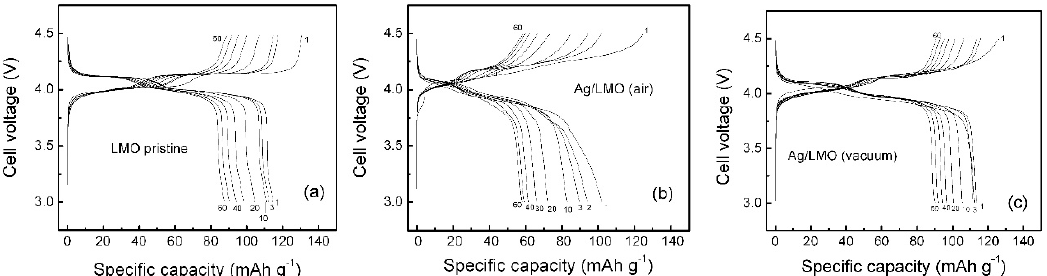
Figure 11. Galvanostatic charge–discharge profiles of Li//LMO cells. Experiments were carried out at 15 mA g − 1 rate in the potential range 3.0–4.5 V over 60 cycles. Positive electrodes are: ( a ) pristine LMO; ( b ) Ag/LMO(a); and ( c ) Ag/LMO(v).